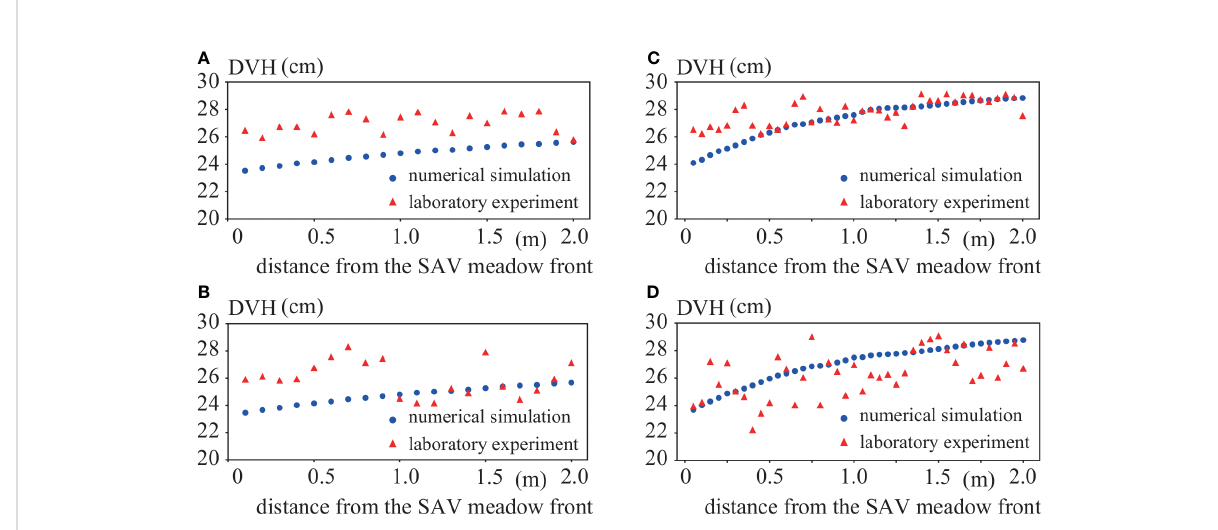
FIGURE 3 Comparisons of DVH between laboratory experiments and numerical simulations. Blue circles and red triangles indicate the laboratory experiment and the numerical simulation, respectively. (A) L1 in case E1, (B) L2 in case E1, (C) L1 in case E2, (D) L4 in case